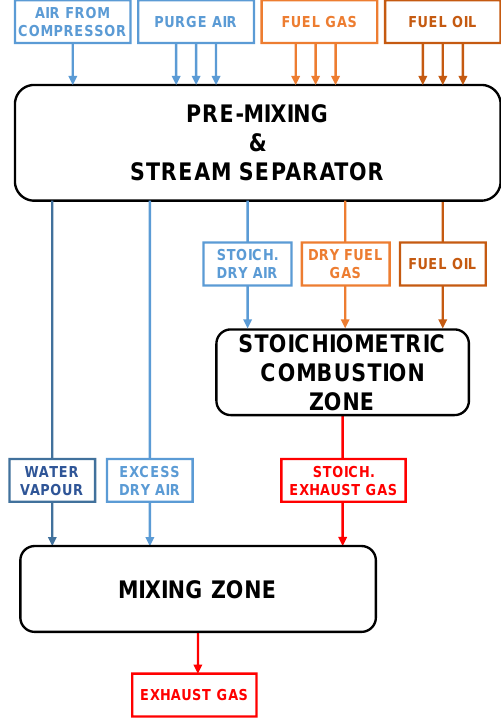
Figure 4. Schematic of the internal structure of TGSim Plus™ combustor block.